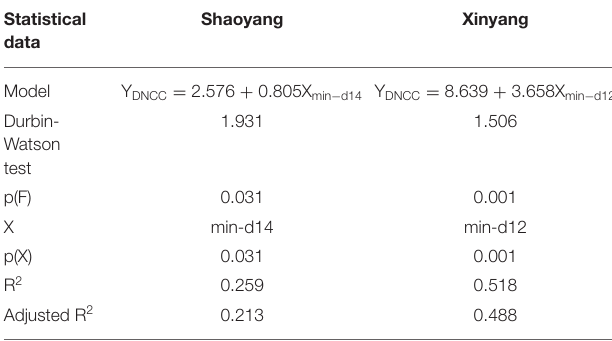
TABLE 5 | Statistical data of the multiple linear regression equation in Shaoyang and